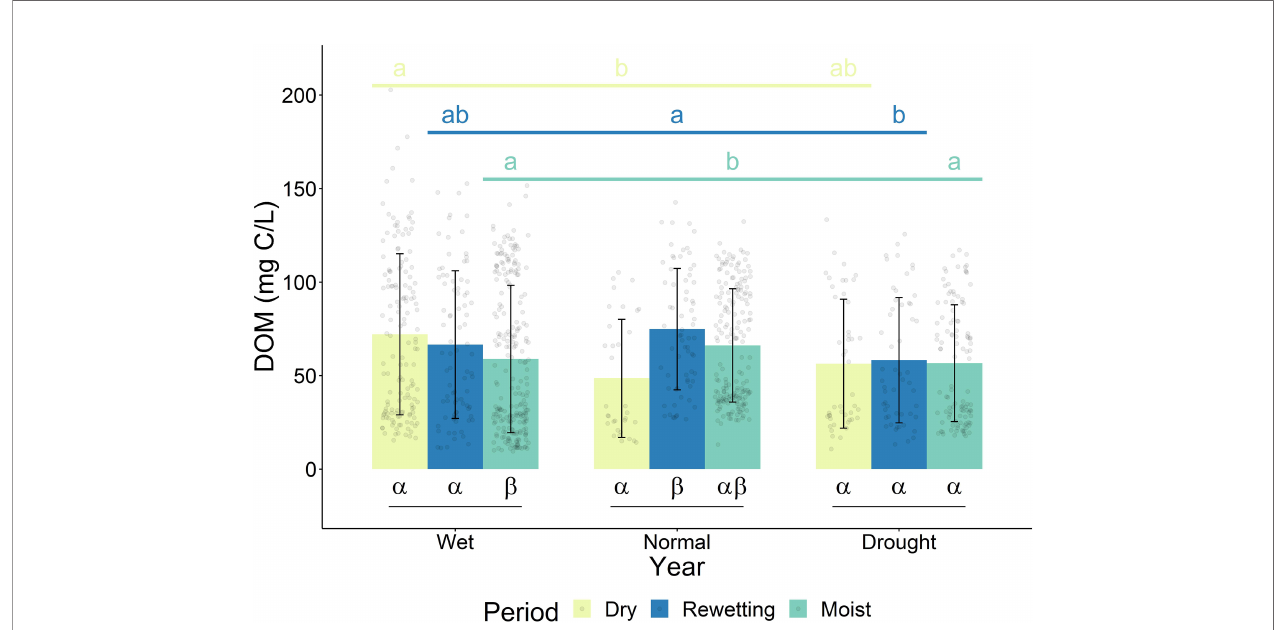
FIGURE 3 | Average and standard deviation of DOM concentration in different years at 5 and 10 cm depth. Greek letters show statistically signi fi cant differences in DOM concentration within years. Lowercase letters indicate statistically signi fi cant differences between the same period of different years. Periods indicate different periods of the year. Signi fi cant differences were determined by linear mixed models and Tukey-adjusted p-values for estimated marginal means (p < 0.05). Outlier calculation was not performed as there is temporal and spatial variation within each group which could be wrongly interpreted as